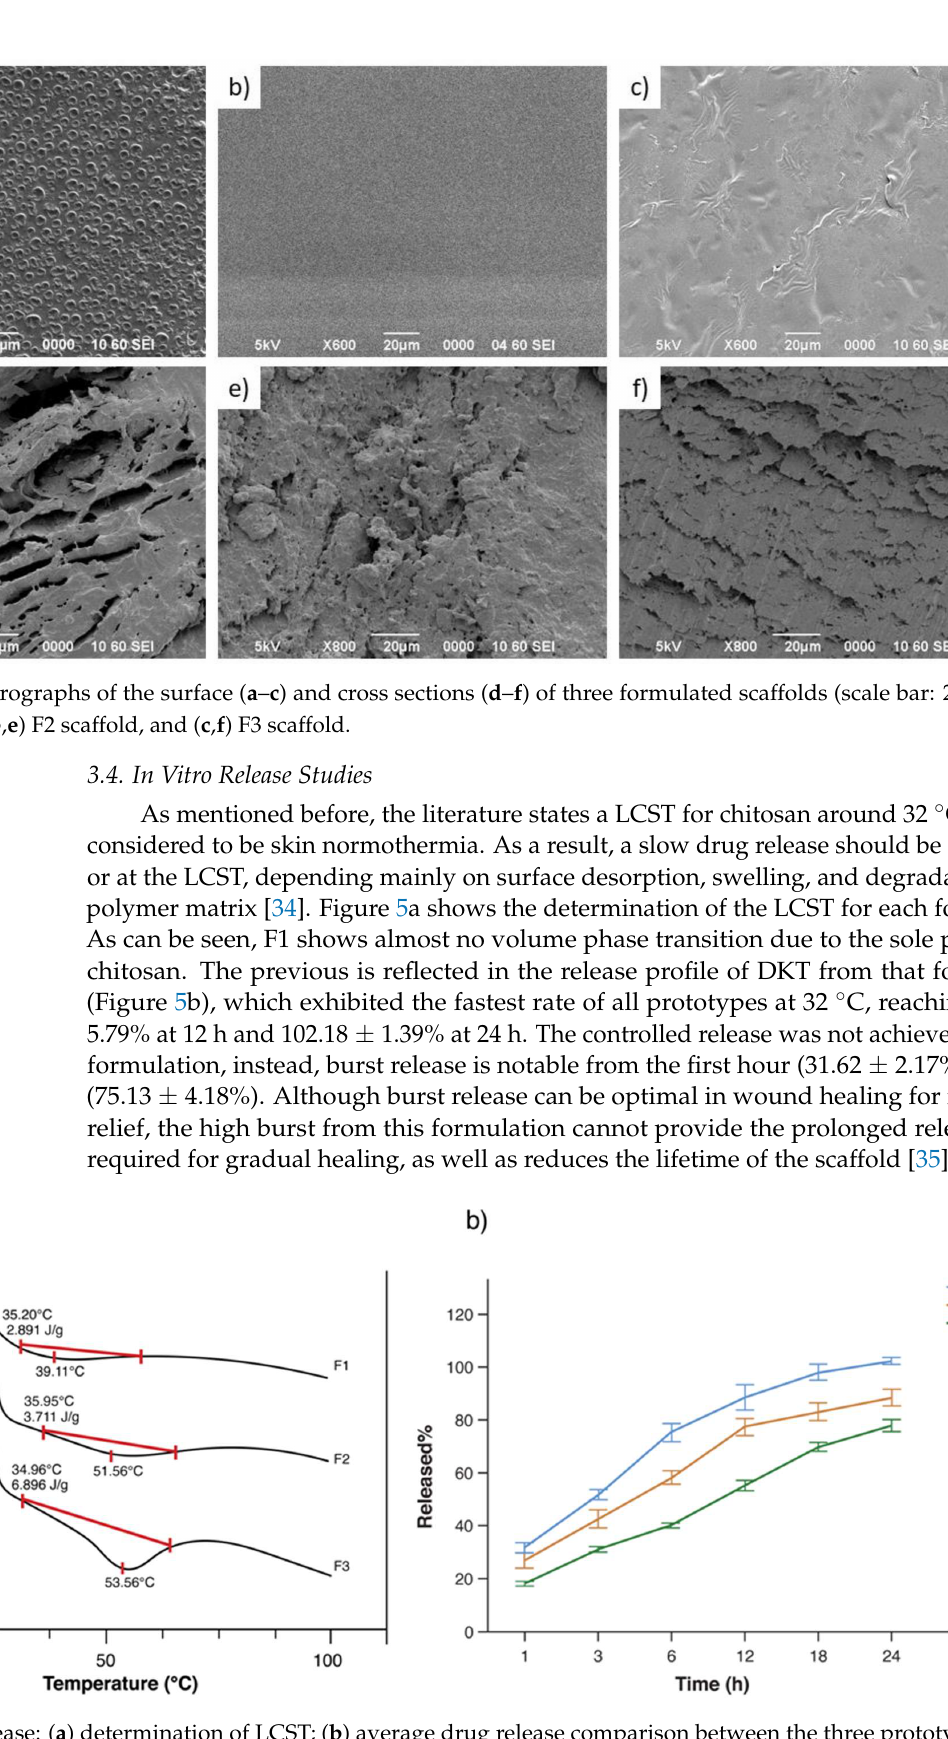
Figure 5. Drug release: ( a ) determination of LCST; ( b ) average drug release comparison between the three prototypes at 32 °C: F1 (blue), F2 (red), and F3 (green) (data are presented as mean of ± standard deviation, n = 6).